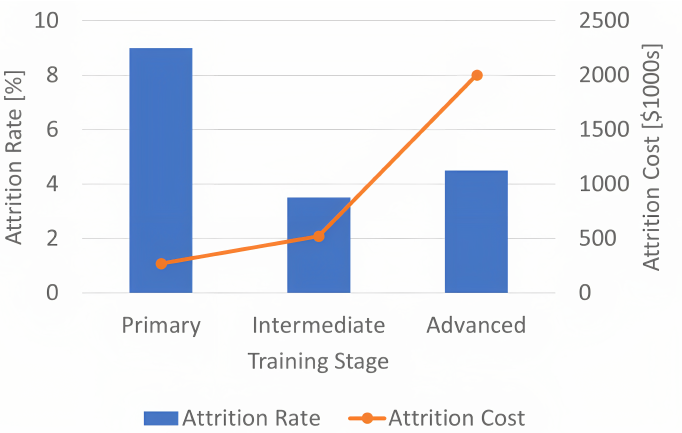
Figure 3. ( Left ): Reason for primary stage attrition by quarter; ( Right ): Distribution of primary stage attrition cost by reason for attrition.